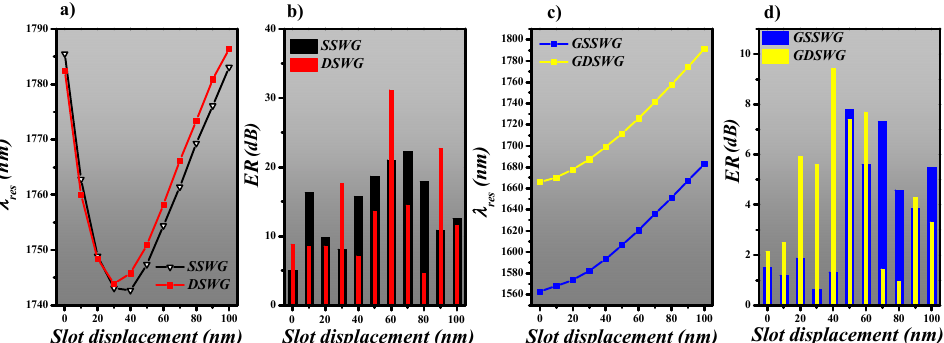
Figure 7. Determination of resonance wavelength of ( a ) SSWG and DSWG, ( b ) GSSWG and GDSWG. Extinction ratio ( ER ) of ( c ) SSWG and DSWG, ( d ) GSSWG and GDSWG. Figure 7c,d present the λ res and ER of GSSWG and GDSWG based ring resonator designs,